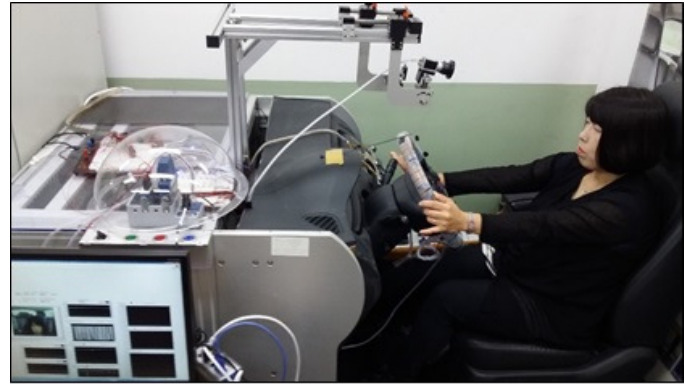
Figure 5. Experimental scenario for collecting access frame data for the center console of the driver monitoring